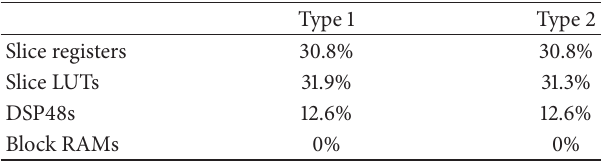
Table 5: Comparing two types of implementations of the abc/dq -